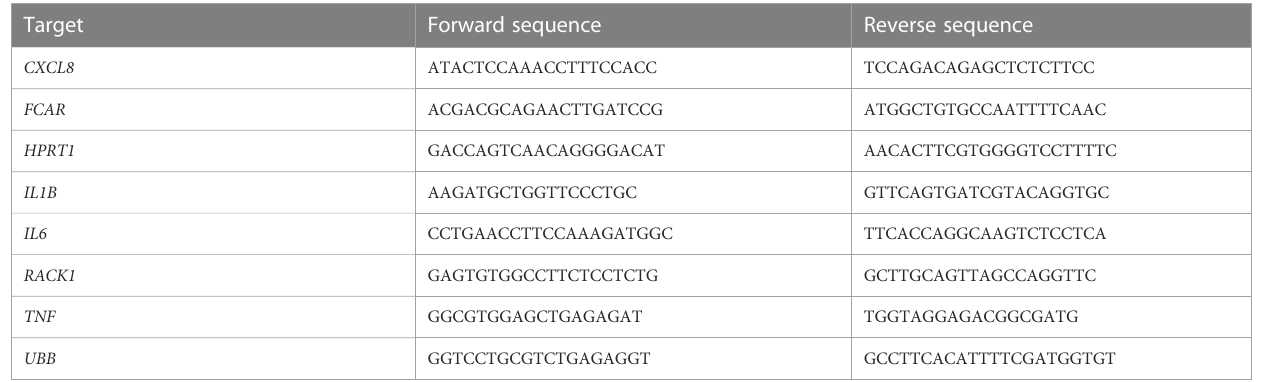
TABLE 1 Primer pairs for quantitative